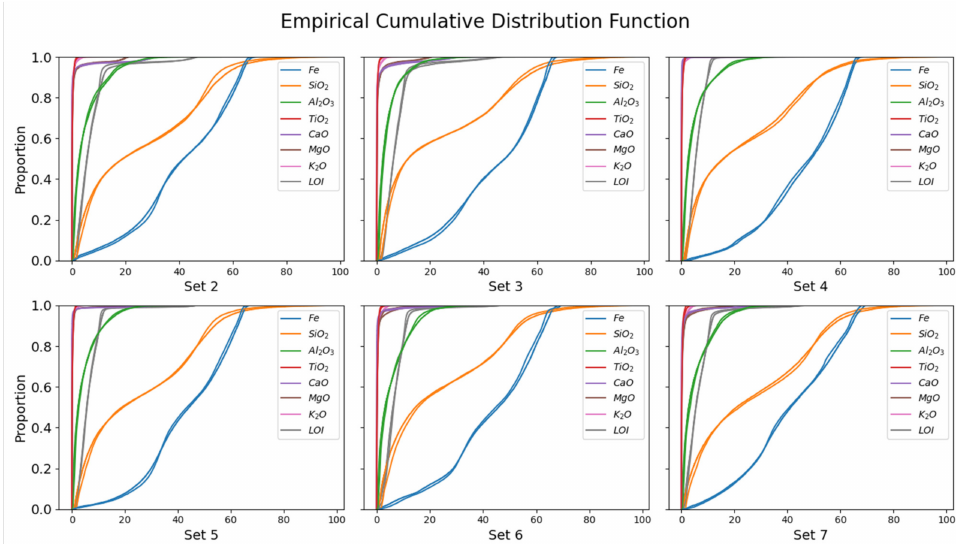
Figure 4. The empirical cumulative distribution of the 8 whole-rock geochemical parameters for the 6 validation datasets (sets 2–7) and the predicted values as returned by the proposed method. A successful prediction over a given dataset should produce a distribution that is the same as the actual distribution. Generally small departures are noted and would indicate that the model is accurately reproducing the true distribution and values. It is noted that the distributions for TiO 2 , CaO, MgO and K 2 O show the range of values for these parameters is extremely small and primarily confined to